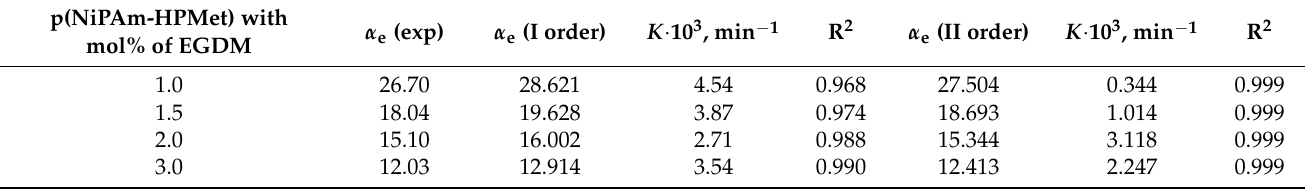
Table 5. Values of the experimentally obtained and calculated normalized equilibrium swelling degree and kinetic parameters of the first and second order reaction at 10 ◦